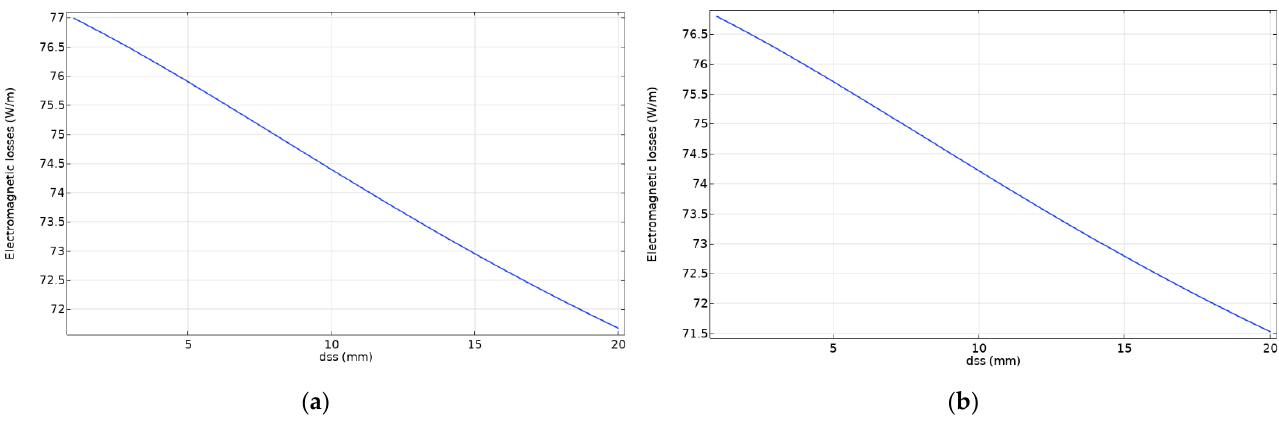
Figure 8. Electromagnetic heating against the distance between busbars of the same phase at 60 Hz for: ( a ) Model 3; ( b ) Model 4.